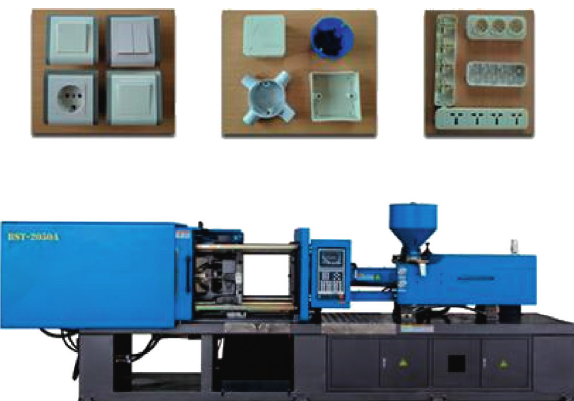
Figure 2: Socket injection modeling machine